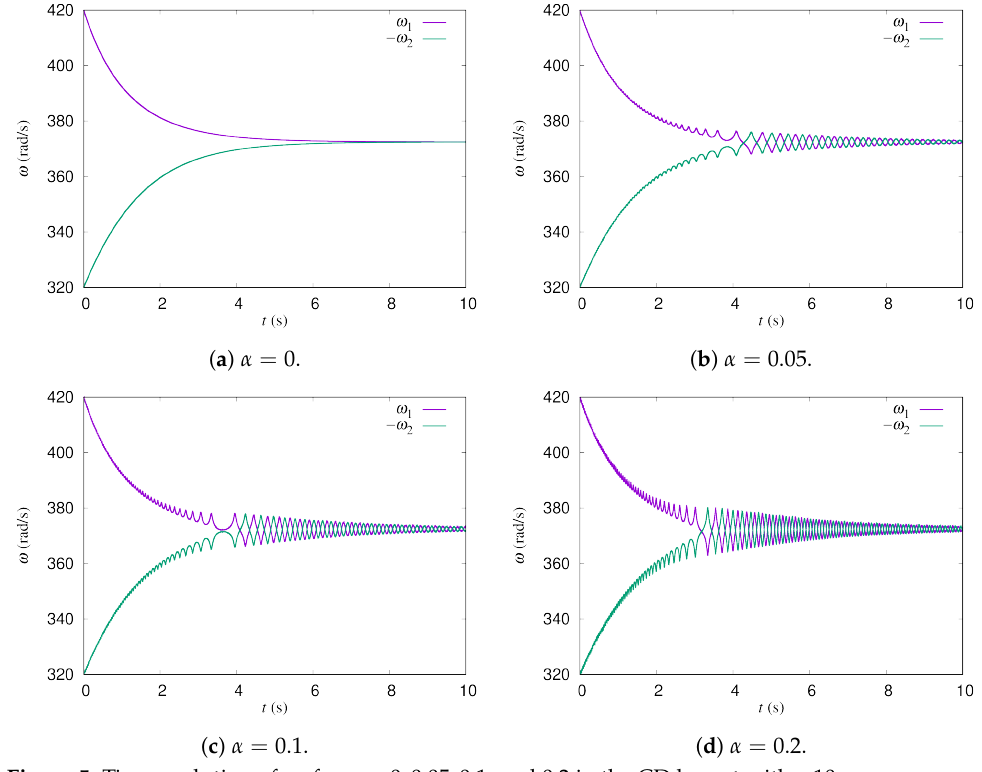
Figure 5. Time evolution of ω i for α = 0,0.05,0.1, and 0.2 in the CD layout with a 10mm gap.